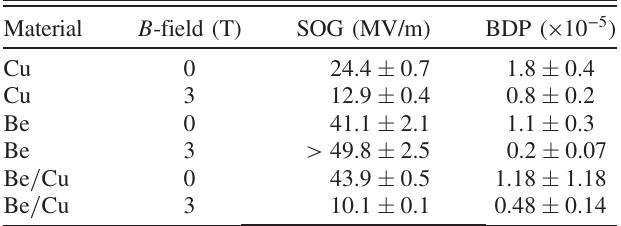
TABLE I. Demonstrated SOG for various cavity configurations and external magnetic field strengths. At each operating point, the breakdown probability (BDP, sparks per pulse) is also shown. “ Be/Cu ” indicates operation with one beryllium and one copper